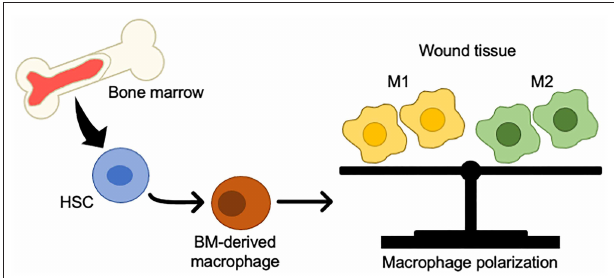
FIGURE 1 | Changes in BMDCs to macrophages in wound tissue. BM-HSCs toward M1/M2 macrophages in injured